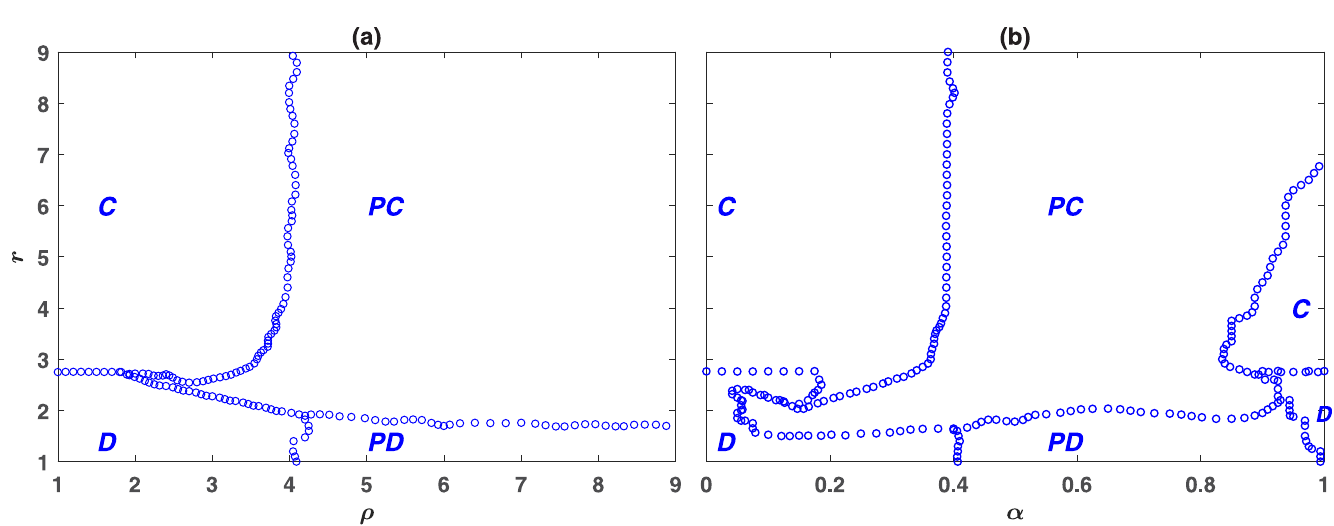
Fig 3. The phase diagram of the wasteful punishment model in a structured population. The phase diagram is derived by running simulations in a population of size 40000, residing on a 200 × 200 first nearest neighbor lattice with Moore connectivity and periodic boundaries. Depending on the parameters of the model, the model shows four different phases. C , D , PC , and PD denote different phases in which, respectively, cooperators, defectors, punishing cooperators, and punishing defectors dominate. Here, g = 9, ν = 0.001, and c = c 0 = 1. In (a) α = 0.5 and in (b) ρ = 5.